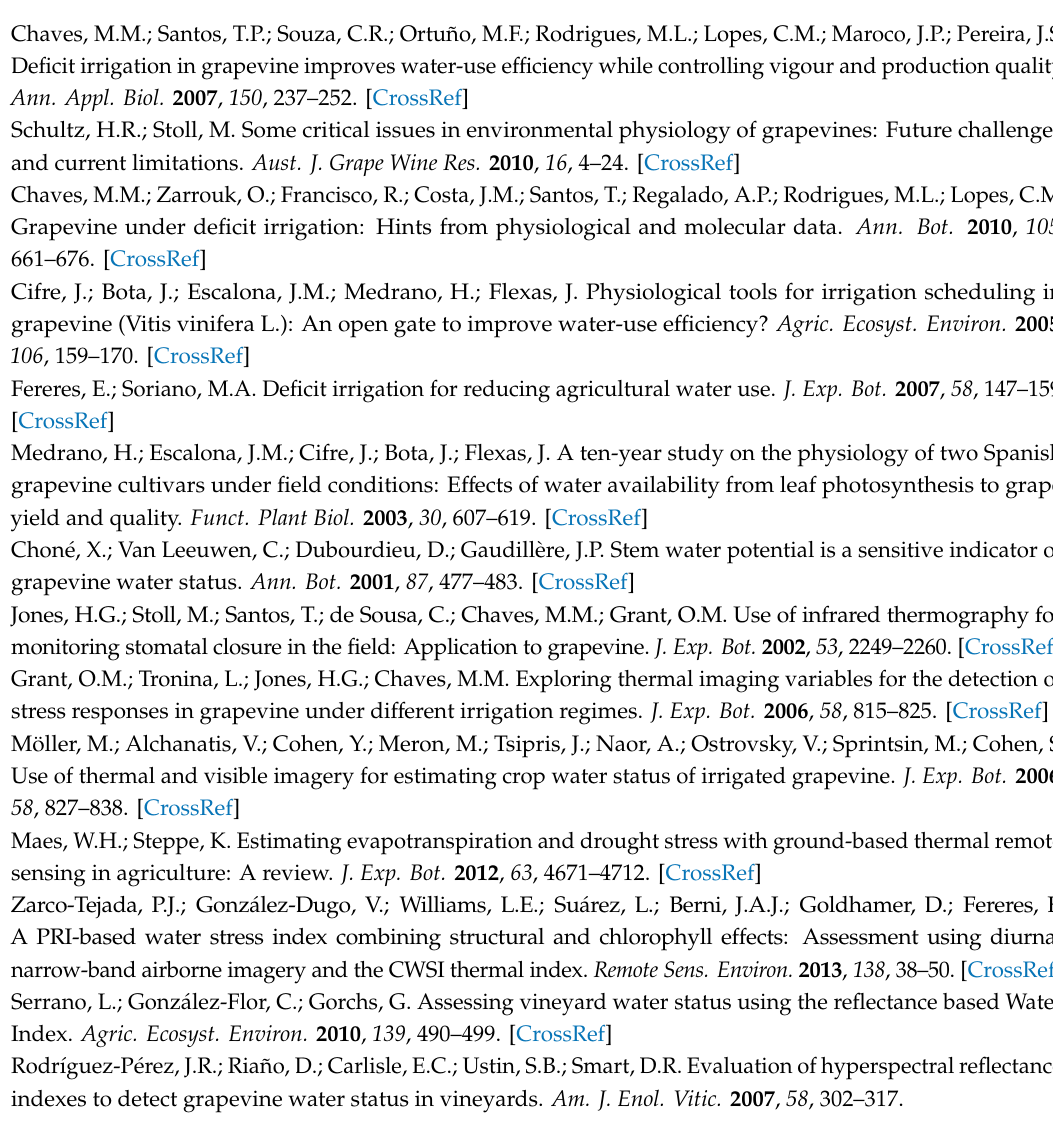
Table S1: E ff ects of mild ( Ψ pd > − 0.4 MPa) and moderate ( − 0.4 MPa < Ψ pd < − 0.6MPa) water deficits on the water index (WI), the normalized water index (WI norm ), the photochemical reflectance index (PRI), and the normalized photochemical reflectance index (PRI norm